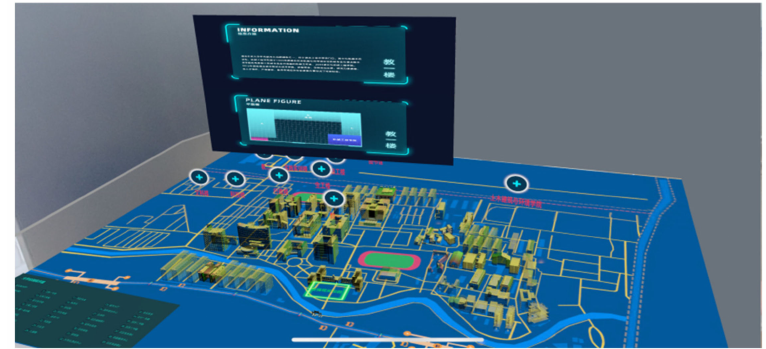
Figure 14. Smart campus in the form of